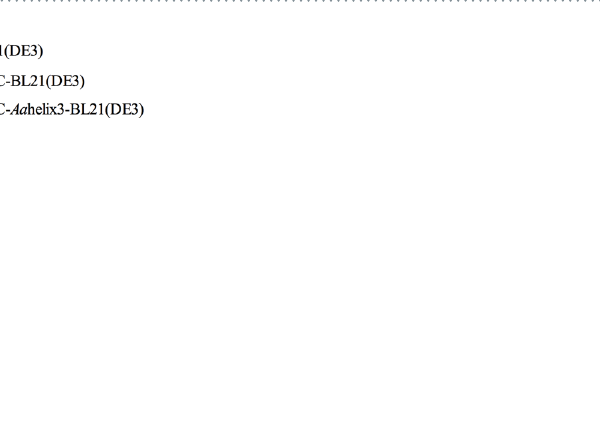
Figure 3. Scanning electron micrographs of derivatives of MinC expression in E. coli BL21(DE3) or MinC-KO. ( A ) E. coli BL21(DE3) (WT); ( B ) Ec MinC- Aa helix3-BL21(DE3); ( C ) Ec MinC CTD -BL21(DE3); ( D ) Ec MinC CTD - Aa helix3-BL21(DE3); ( E ) BW25113; ( F ) MinC-KO; ( G ) Ec MinC-MinC-KO; ( H ) Ec MinC- Aa helix3-MinC-KO. Cells of Ec MinC CTD - Aa helix3 exhibited much longer cell morphology than WT ( A ~ D ) and complementation of MinC-helix3 to MinC-KO strains could not help cells regain the ability of cell division regulation ( E ~ H ), verifying that the Aa helix3 influenced the normal cell division in cells. Scale bars represent 5 μ m.